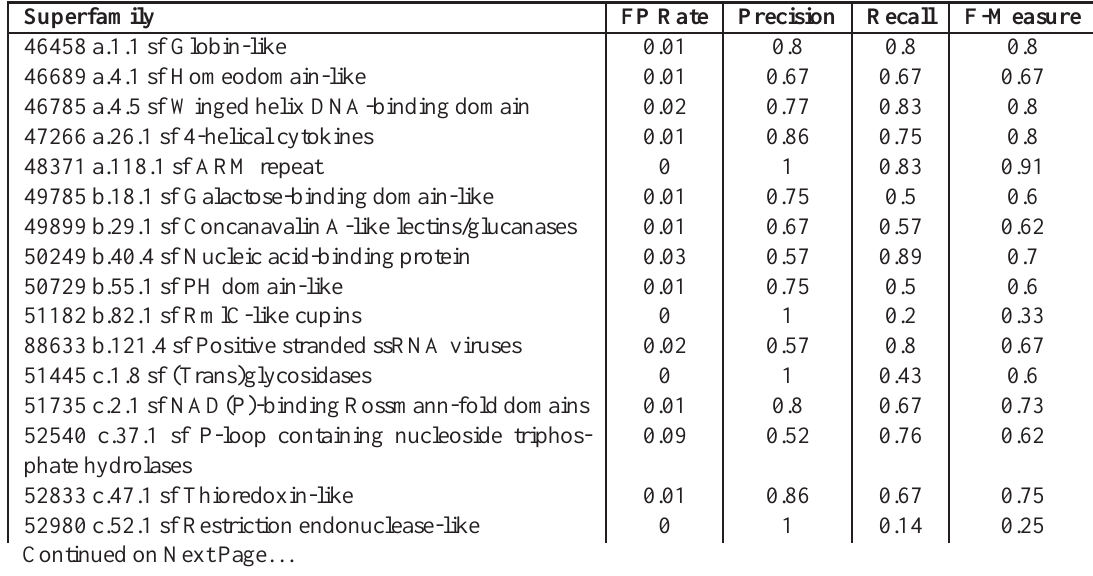
Table 4: Performance in prediction of each of 24 SCOP superfamilies (analysis that excluded multi domain proteins) studied using Support Vector Machines (LibSVM) with enrichment at a redundancy cutoff of 30% (FP=false